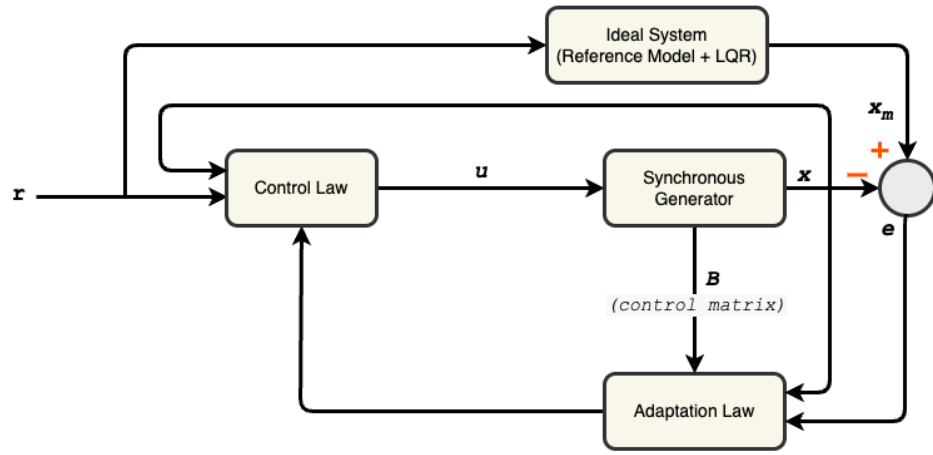
Figure 2. Typical Model-Reference Adaptive Control